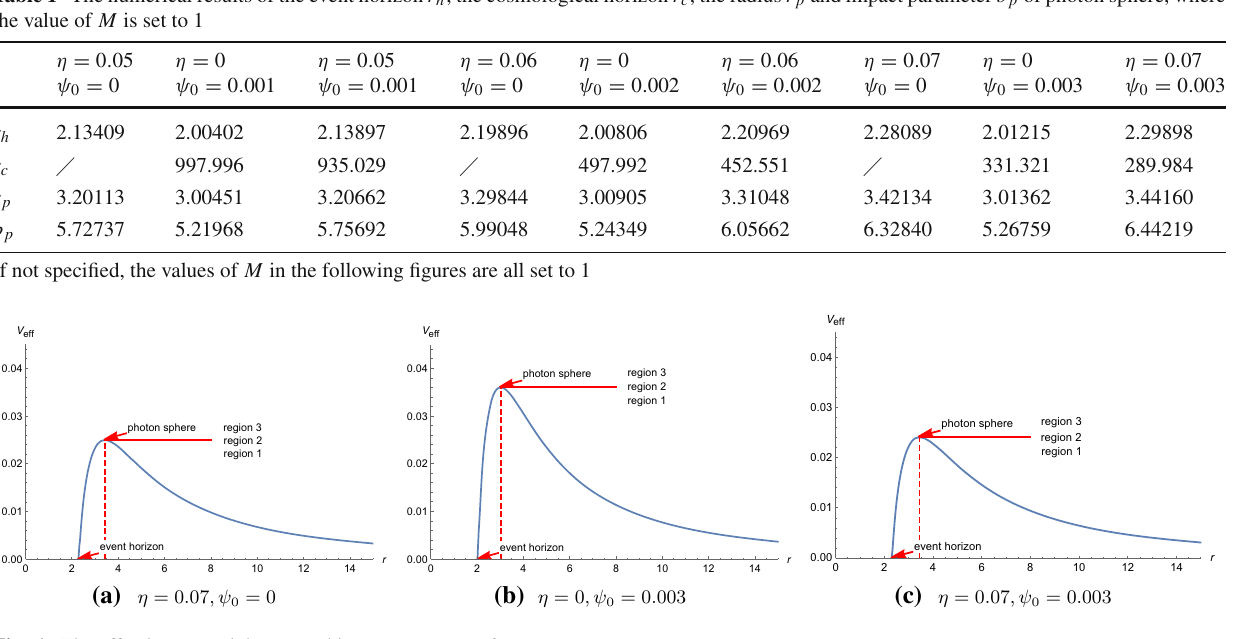
Fig. 1 The effective potential V ef f and impact parameter b c versus